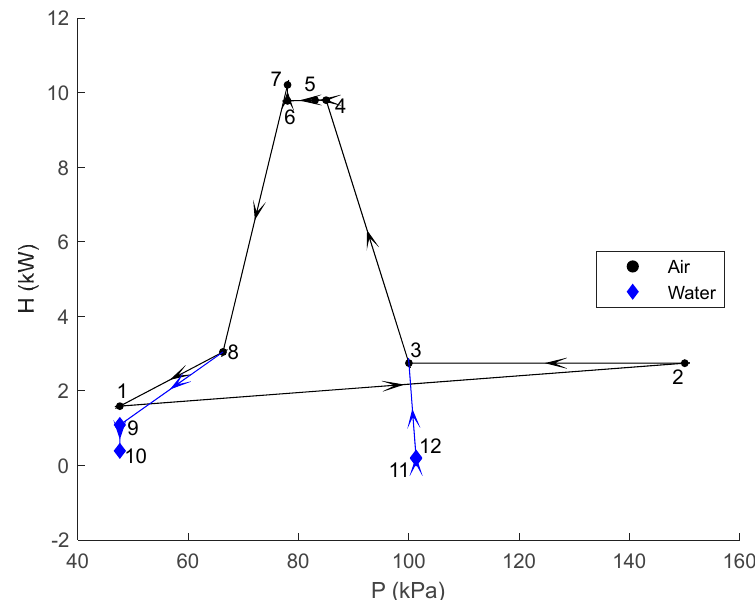
Figure 4. H-P diagram for baseline operation.